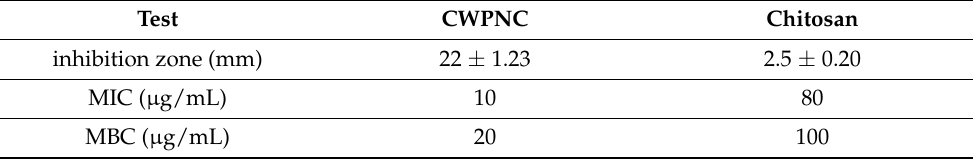
Table 2. The inhibition zone, MIC, and MBC of CWPNC and chitosan against S. agalactiae